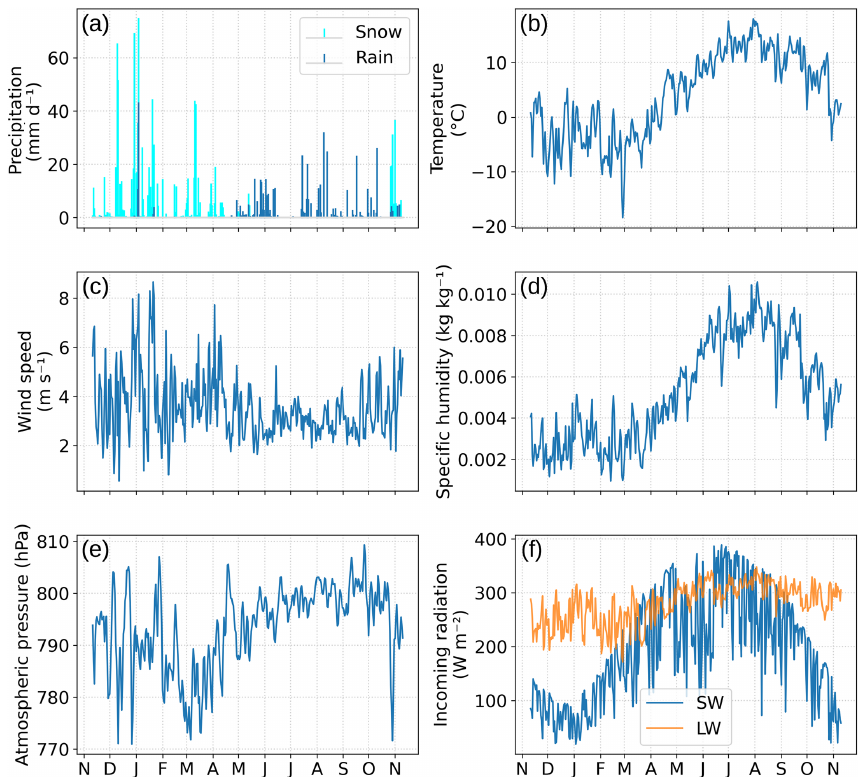
Figure 2. Daily meteorological observation at Col du Lautaret for the hydrological year 2017–2018: precipitation (a) , air temperature (b) , wind speed (c) , specific humidity (d) , atmospheric pressure (e) , and shortwave (SW) and longwave (LW) incoming radiation (f)